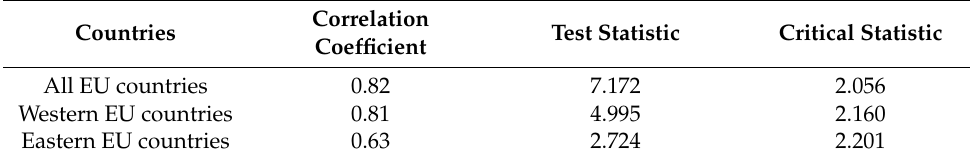
Table 7. Pearson’s correlation coefficient for amount of food exported within intra EU-trade (in billions of kg, according to the SITC) and number of notifications on food (according to the RASFF). Correlation Test Countries Coefficient